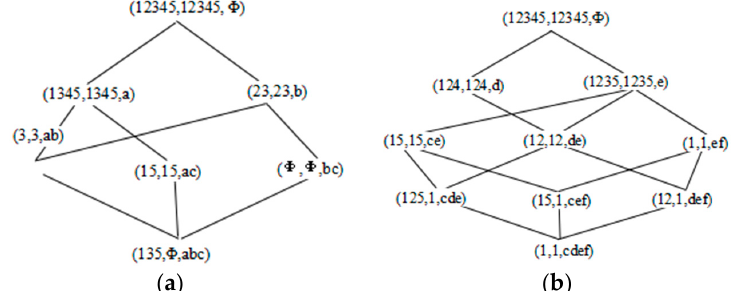
RAUL β L ; ( b ) The lattice structure ),,( of 1 β ( U , A ) of L β α α 11 α α 1; ( b ) The lattice structure L 1 , R 1